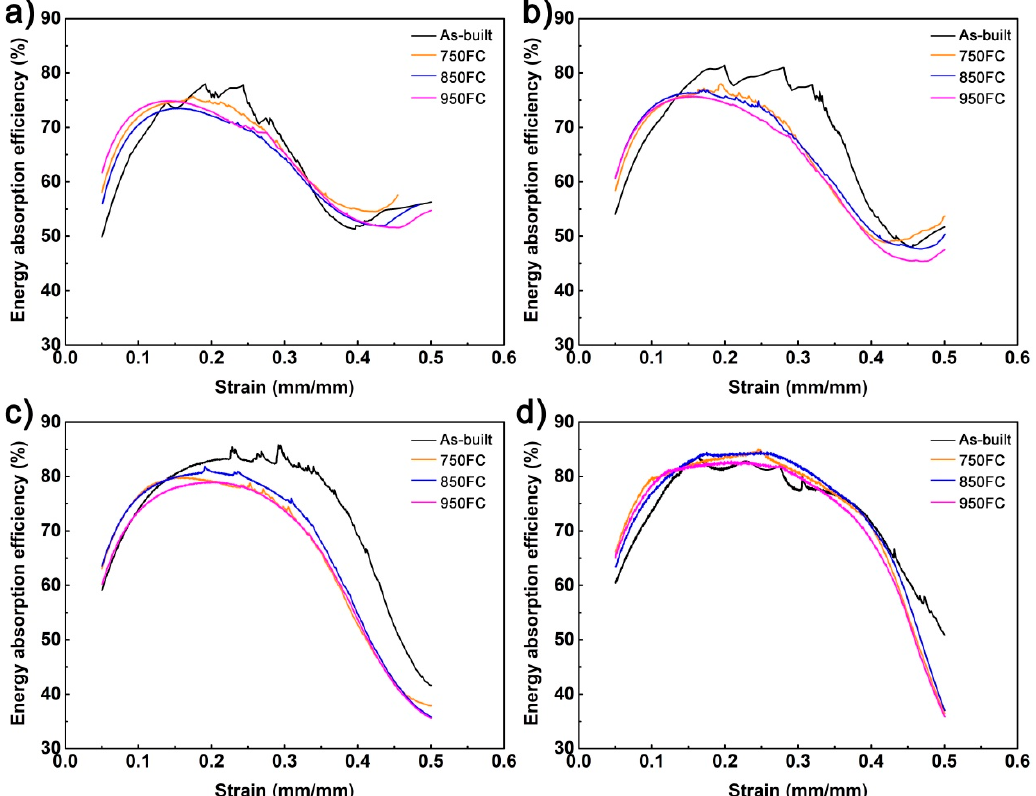
Figure 13. The energy absorption efficiency curves of porous Ti64 structures with different porosities after different heat treatments: ( a ) 46.3%; ( b ) 56.3%; ( c ) 66.2%; ( d ) 75.4%.